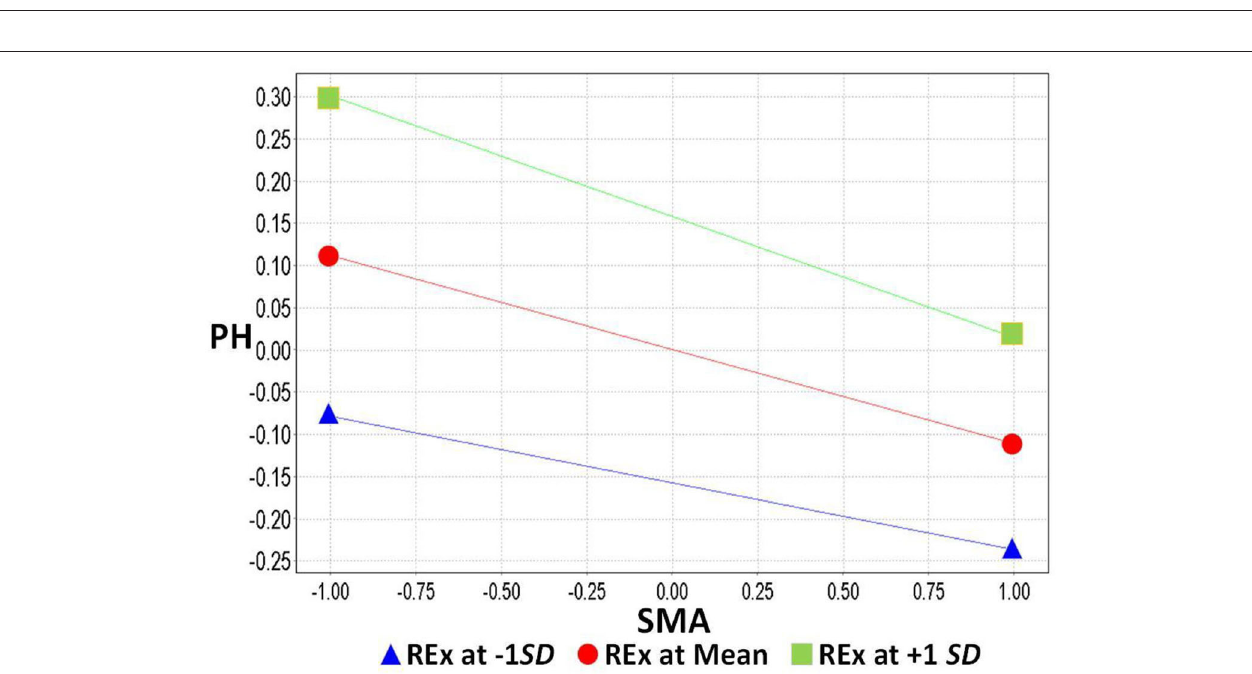
FIGURE 4 | The moderating effect of regular exercise on social media addiction and perceived health.